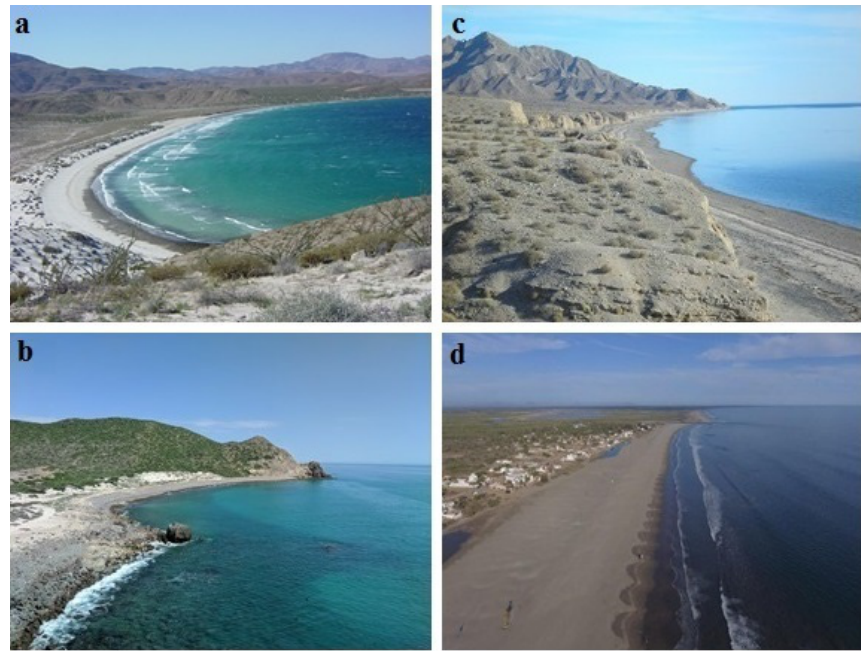
Figure 2. Images of the west and east coasts of the Gulf of California (GC): ( a ) Baja California (B.C.); ( b ) Baja California Sur (B.C.S.); ( c ) Sonora; ( d ) Sinaloa. Source: Google Earth (2018).